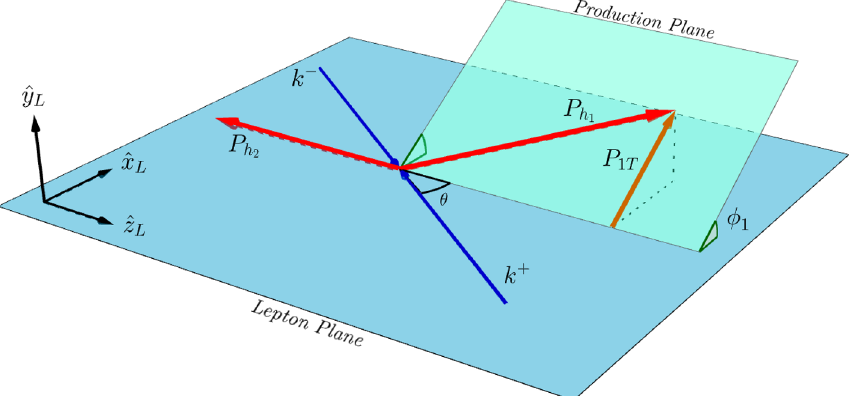
Figure 2 . Kinematics for the hadron-frame